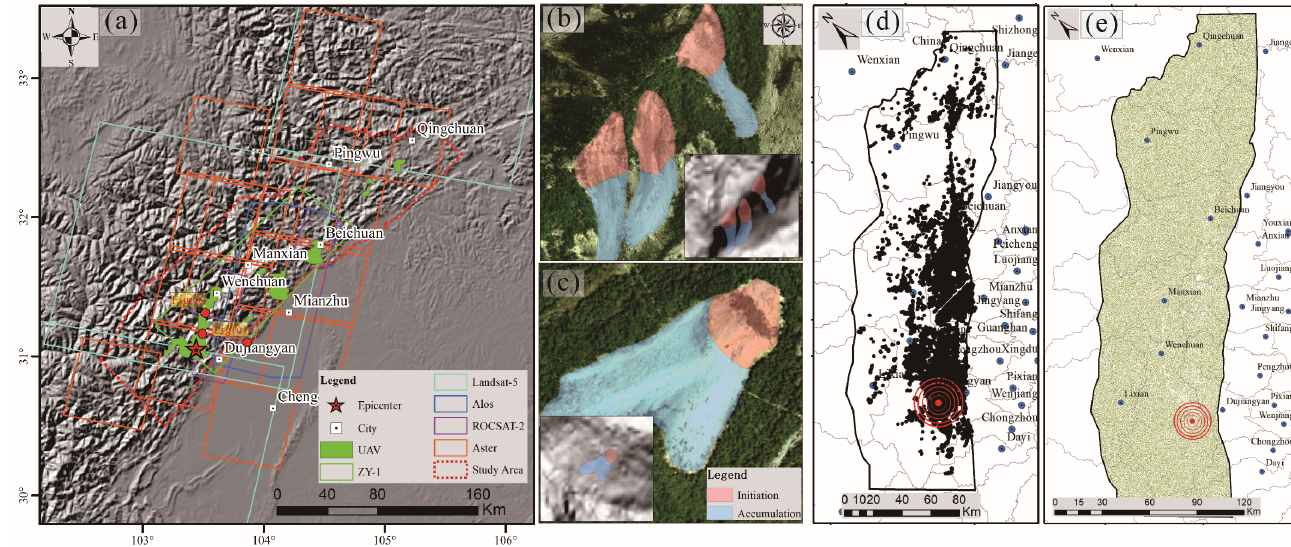
Figure 4. Post-earthquake remote sensing image coverage and example of source area extraction of EQIL: ( a ) remote sensing coverage used in this paper. ( b , c ) Identification of EQIL source area. ( d ) Positive samples. ( e ) Negative sample.